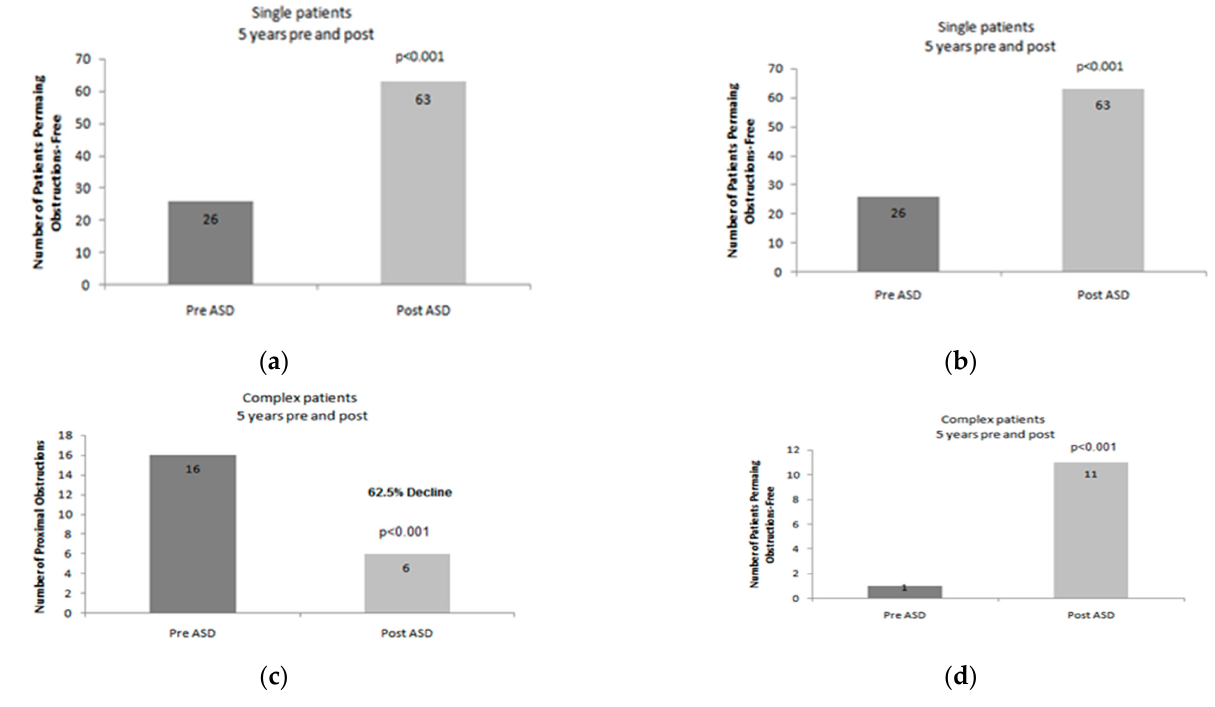
Figure 2. Proximal shunt revision rates after ASD placement in “complex” patients. ( a ): Graphical illustration of the 1-year number of proximal shunt revisions after ASD implantation in “complex” shunt patients. ( b ): Graphical illustration of the number of patients with no proximal shunt obstruction during the study period (1-year). ( c ): Graphical illustration of the 5-year number of proximal shunt revisions after ASD implantation in “complex” shunt patients. ( d ): Graphical illustration of the number of patients with no proximal shunt obstruction during the study period (5-years).